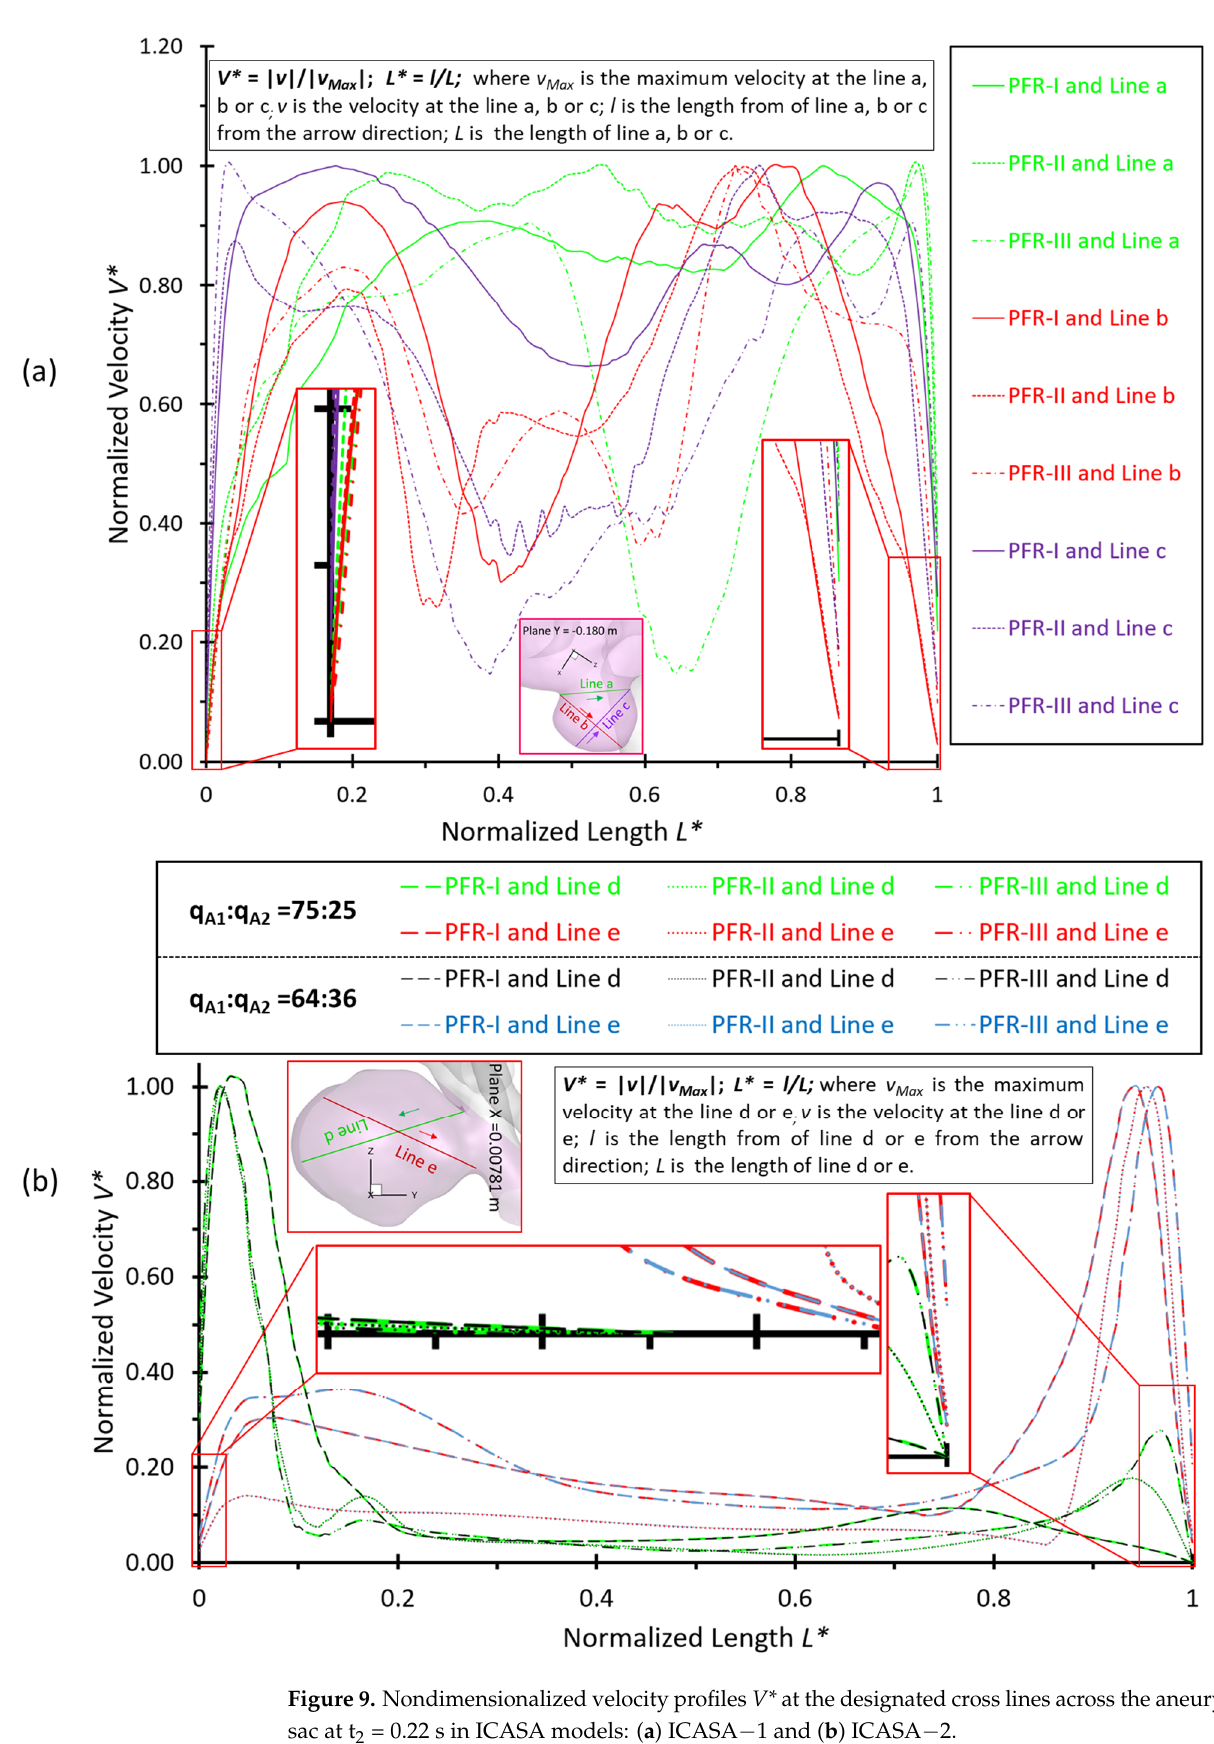
Figure 9. Nondimensionalized velocity profiles V* at the designated cross lines across the aneurysmal sac at t 2 = 0.22 s in ICASA models: ( a ) ICASA−1 and ( b ) ICASA−2.